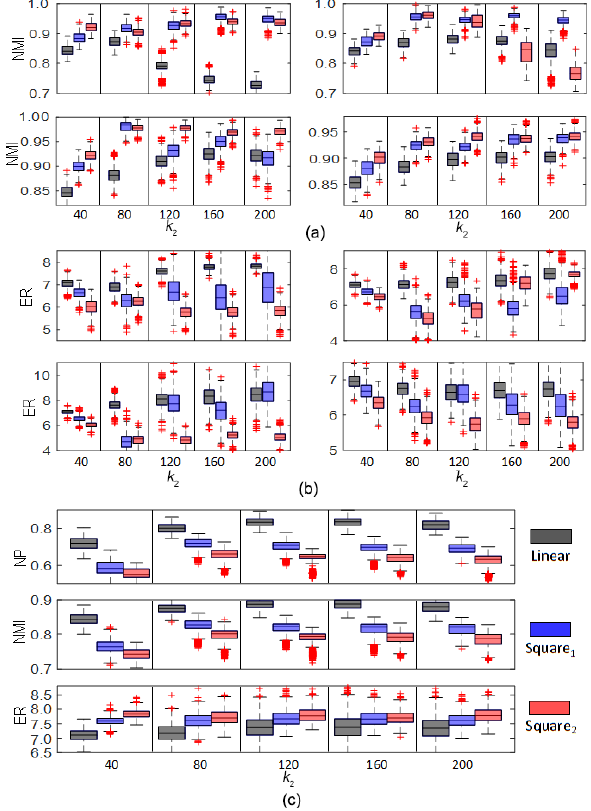
Fig. 7 Comparison among linear and nonlinear models. Square 1 means that we only added nonlinear function onto H 1 , whereas Square 2 means that both H 1 and H 2 are projected by the nonlinear function. The classification precisions in terms of the NMI of DNMF, SDNMF/R, SDNMF/L, and SDNMF/RL2 are shown in (a) and (b), respectively. The results of SDNMF/RL1 in terms of NP, NMI, and ER are shown in